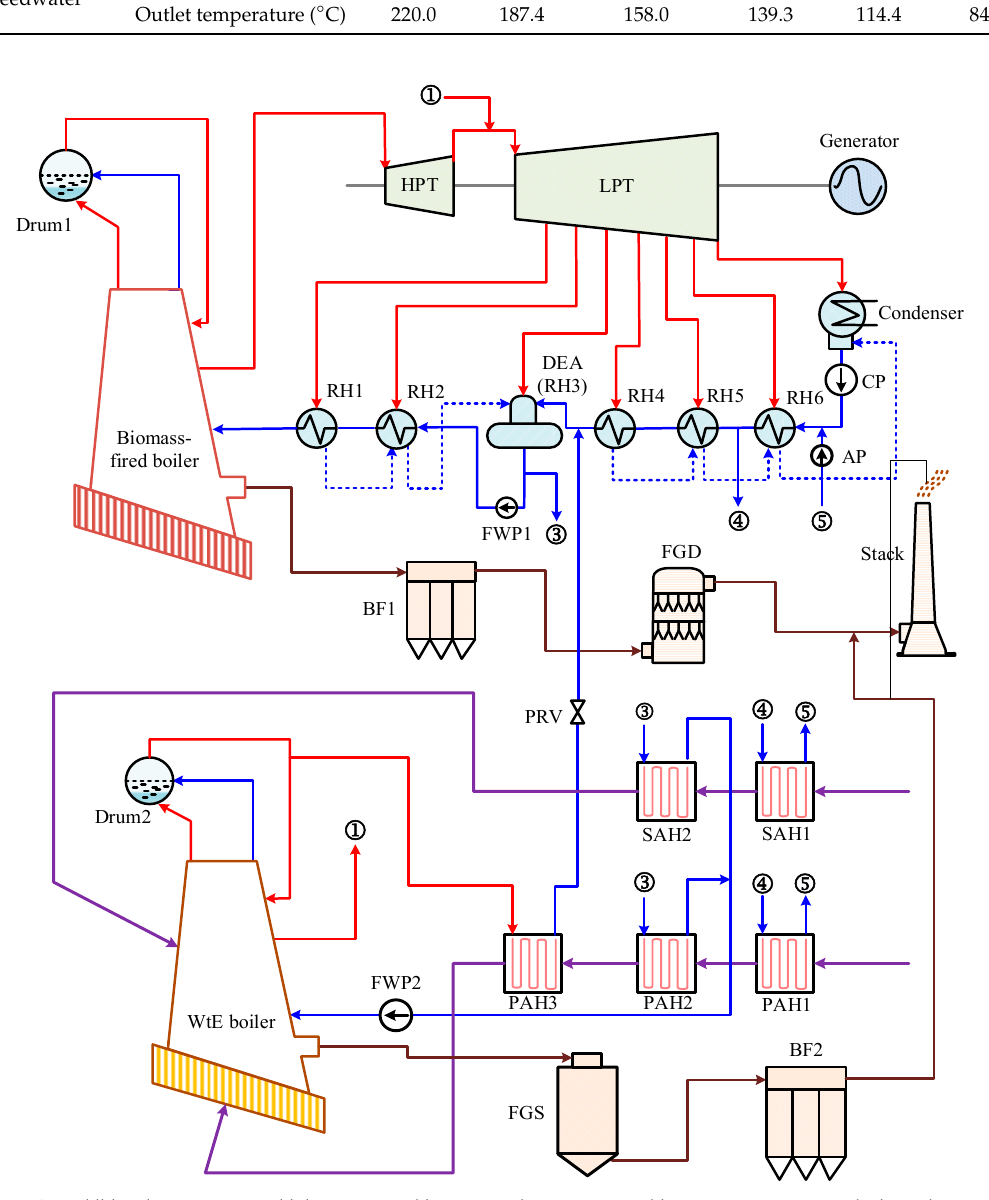
Figure 3. Proposed WtE system integrated with a biomass-fired power plant. Table 7. Comparison of the simulation results and design data of the reference biomass-fired power plant.